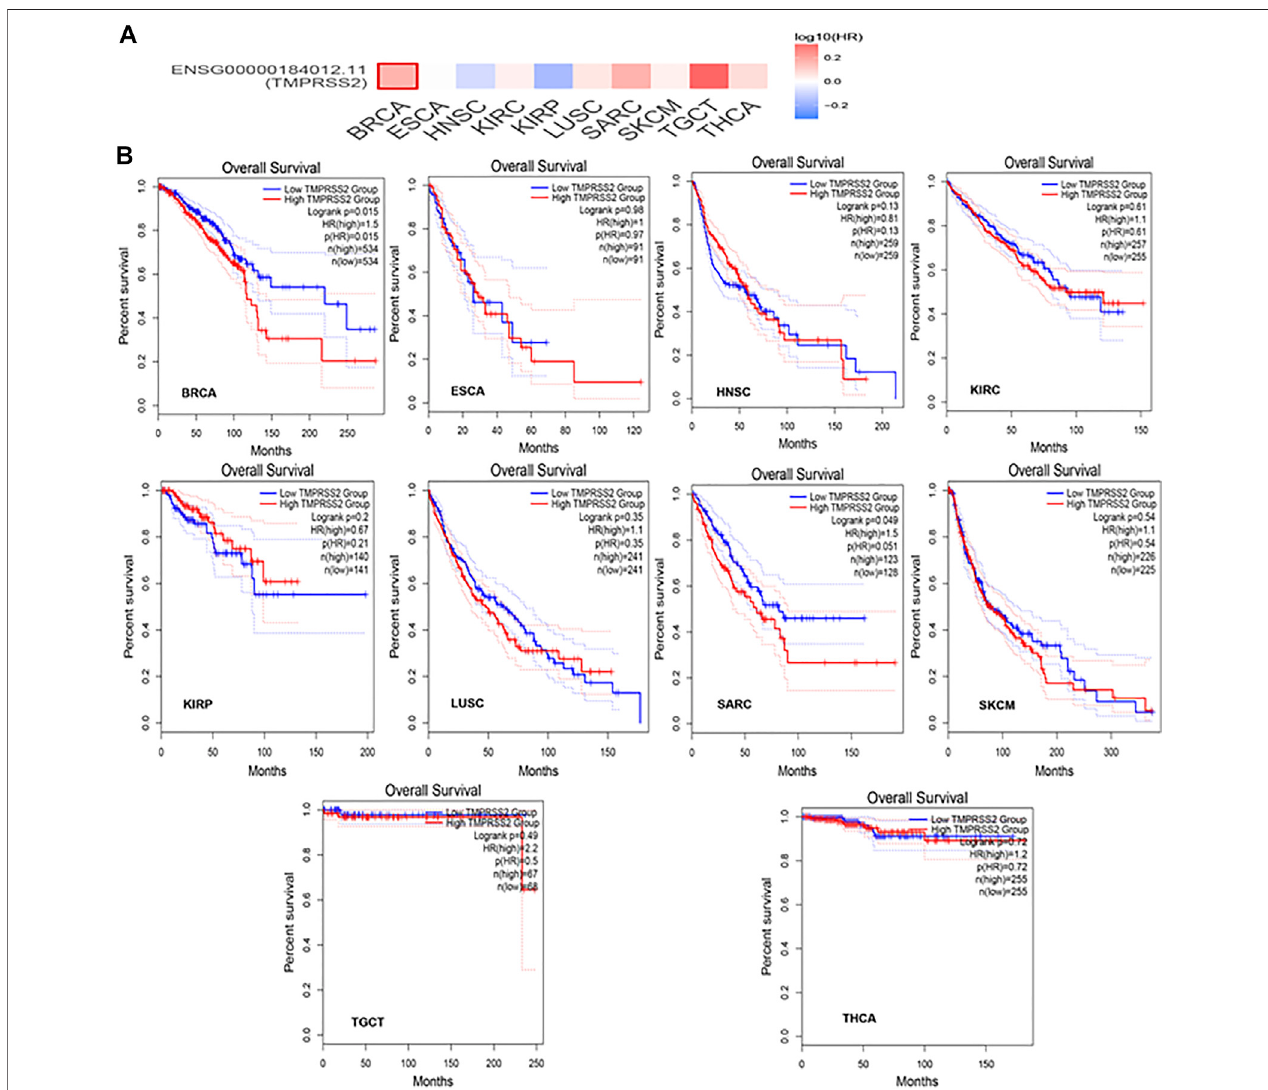
FIGURE 9 | TMPRSS2 expression unchanged in some of the tumors. There was no difference in the expression of TMPRSS2 in some tumors and normal tissues, includingadrenocorticalcarcinoma(ACC),bladderurothelialcarcinoma(BLCA),cholangiocarcinoma(CHOL),lymphoidneoplasmdiffuselargeB-celllymphoma(DLBC), acute myeloid leukemia (LAML), brain lower grade glioma (LGG), ovarian serous cystadenocarcinoma (OV), stomach adenocarcinoma (STAD), thymoma (THYM), pancreatic adenocarcinoma (PAAD), and even lung adenocarcinoma (LUAD).